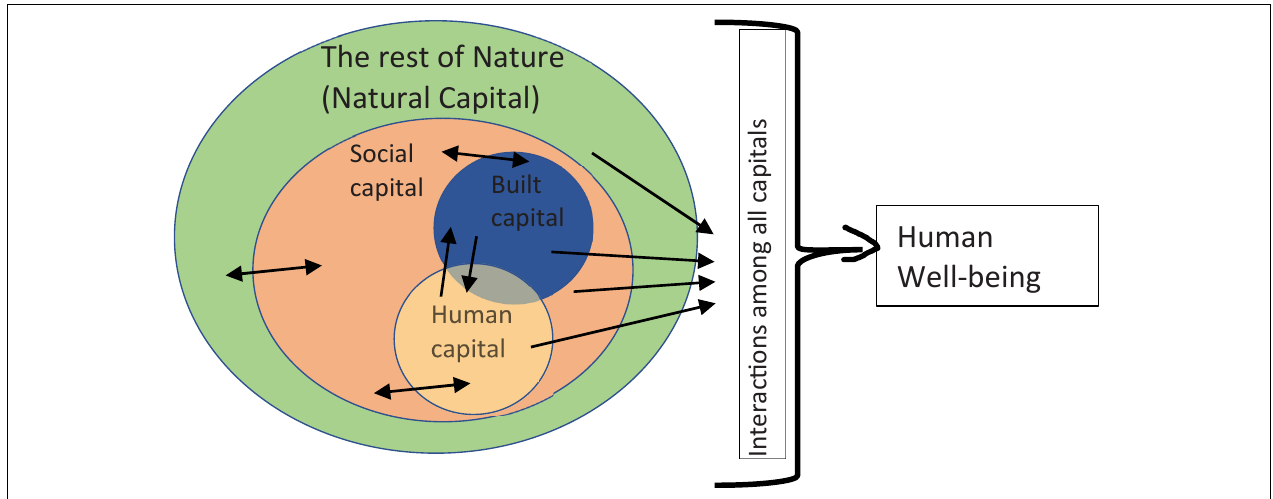
FIGURE 2 | Natural capital as the foundation for social, built, and human capitals, the latter are typically considered for measuring economy, however, the foundation is omitted. It is important to note that interactions between different capitals deliver human wellbeing—a much better target to improve and measure economies (adapted from Costanza et al.,